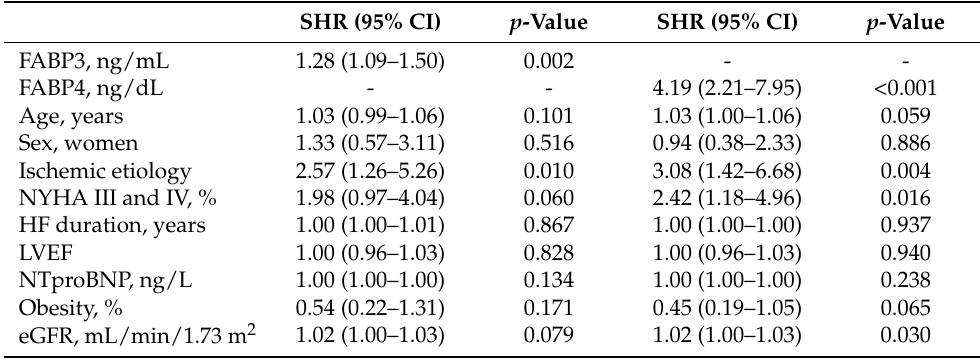
Table 3. Competitive risk analysis for the FABP3 and FABP4 concentrations and cardiovascular mortality in subjects with T2D.